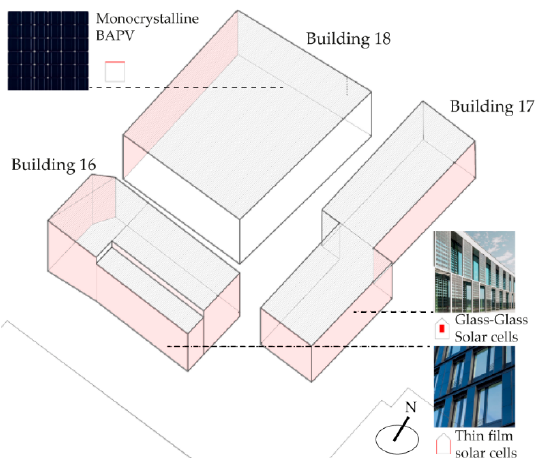
Figure 19. Solar technology recommendations for the critical area for the existing situation.